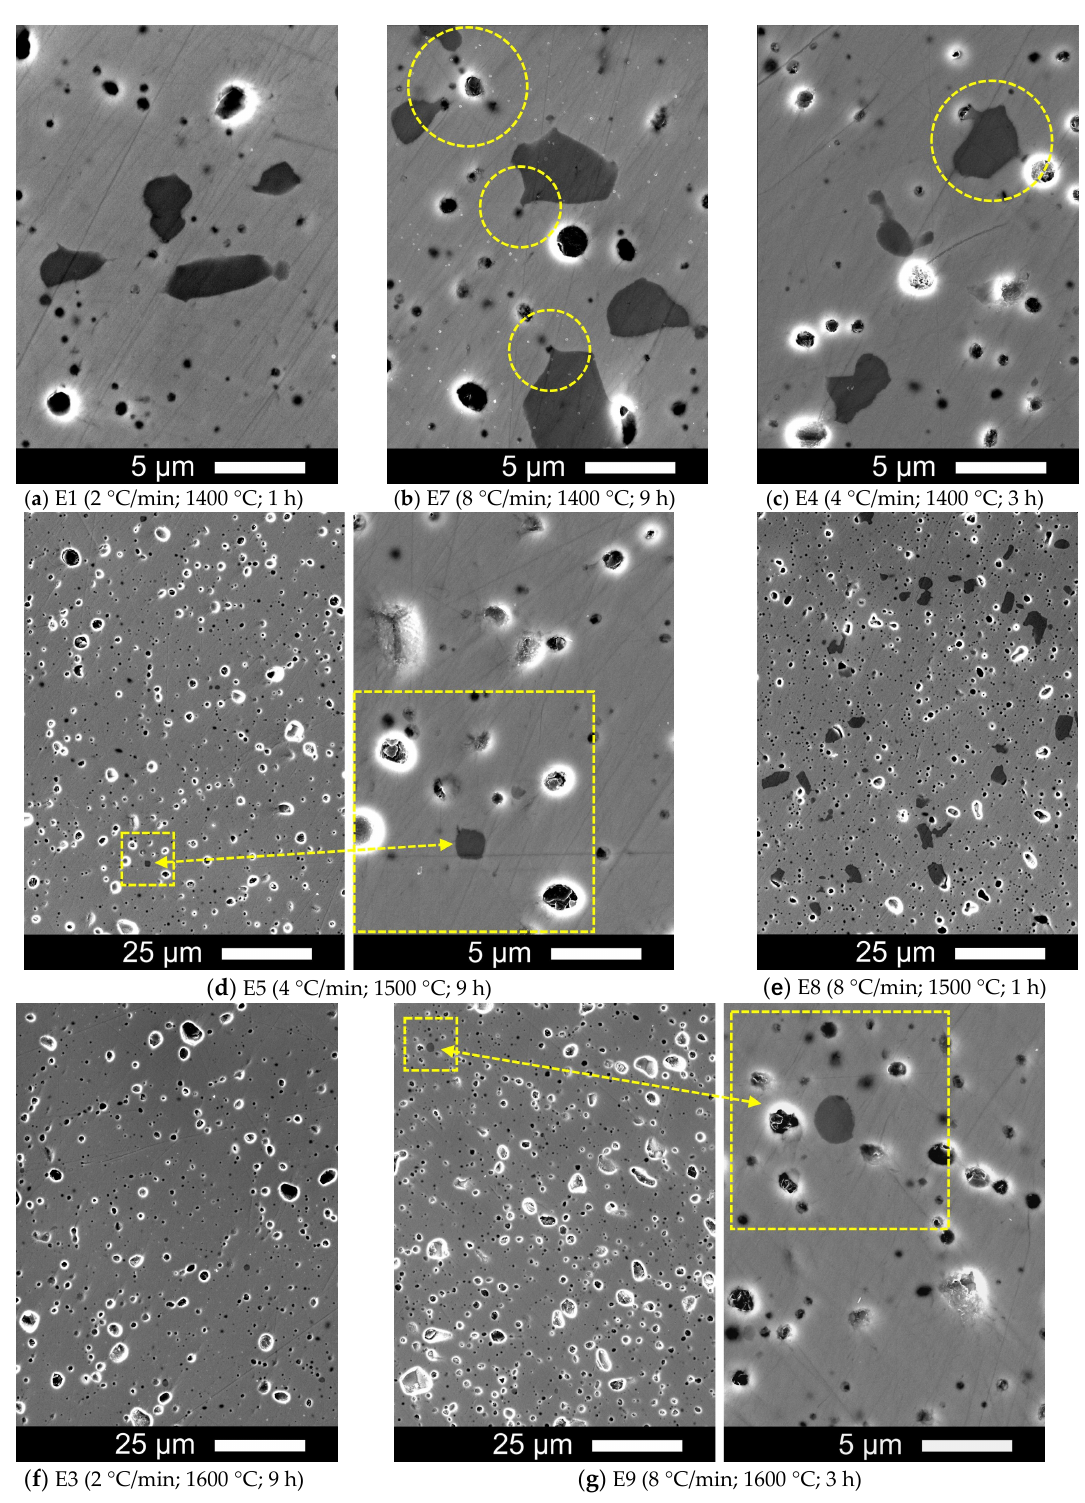
Figure 5. Scanning electron microstructures of samples processed with different firing schedules: ( a ) E1 (2-14-1), ( b ) E7 (8-14-9), ( c ) E4 (4-14-3), ( d ) E5 (4-15-9), ( e ) E8 (8-15-1), ( f ) E3 (2-16-9), and ( g ) E9 (8-16-3). Micrographs show dispersed Mn-rich dark spots in E1 (2-14-1), based on high differences in the atomic weight of Mn, Zr and Y. Circles in E7 (8-14-9) and E4 (4-14-3) microstructures show links between Mn-precipitates and residual pores.